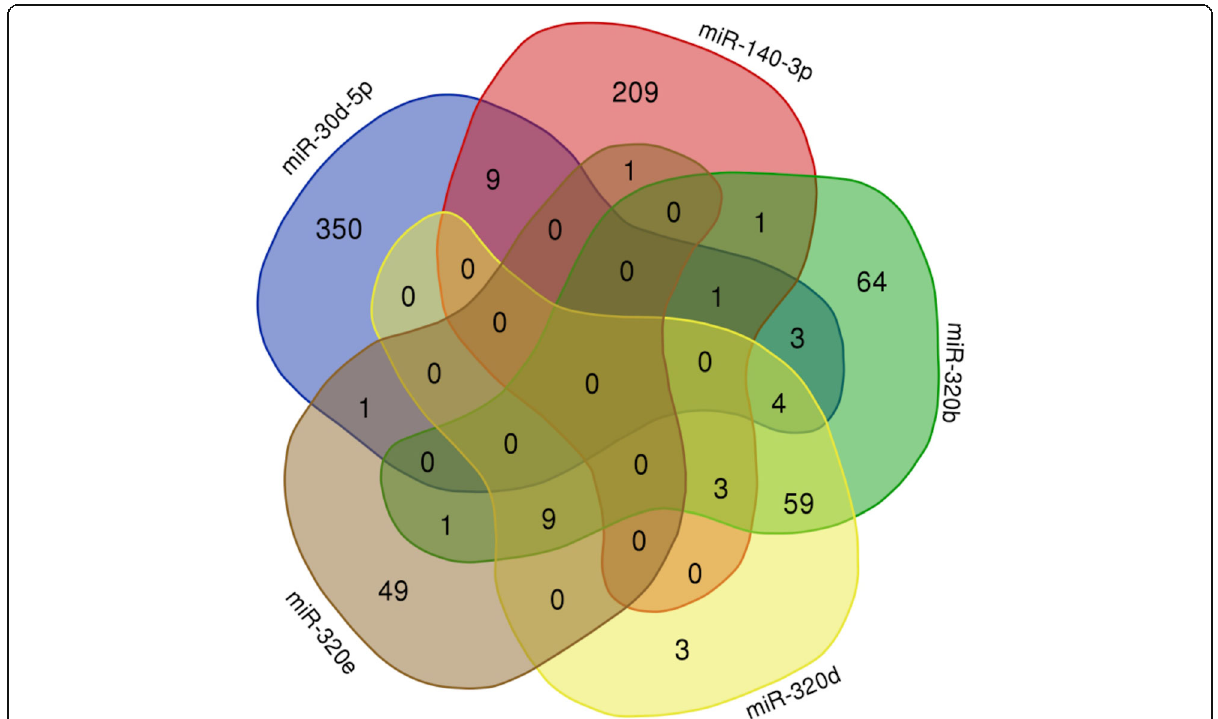
Fig. 8 Intersection of the target genes of the top five